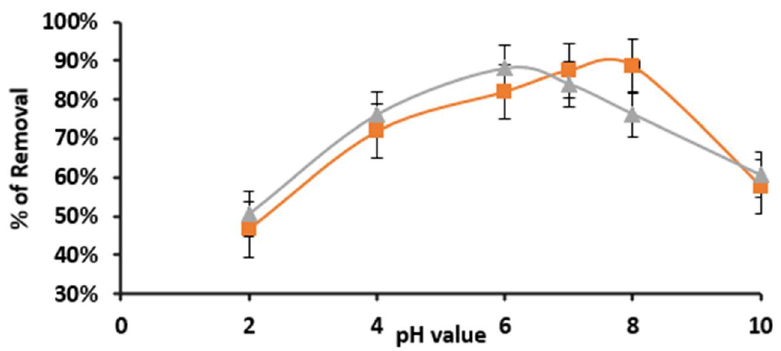
Figure 5. Effect of pH value on adsorption efficiency of Cell-X and Cell-D (C I : 10 ppm, dosage: 10 mg, volume: 10 mL, temperature: 20 °C, time: 20 min of Cell-D, time: 60 min of Cell-X).